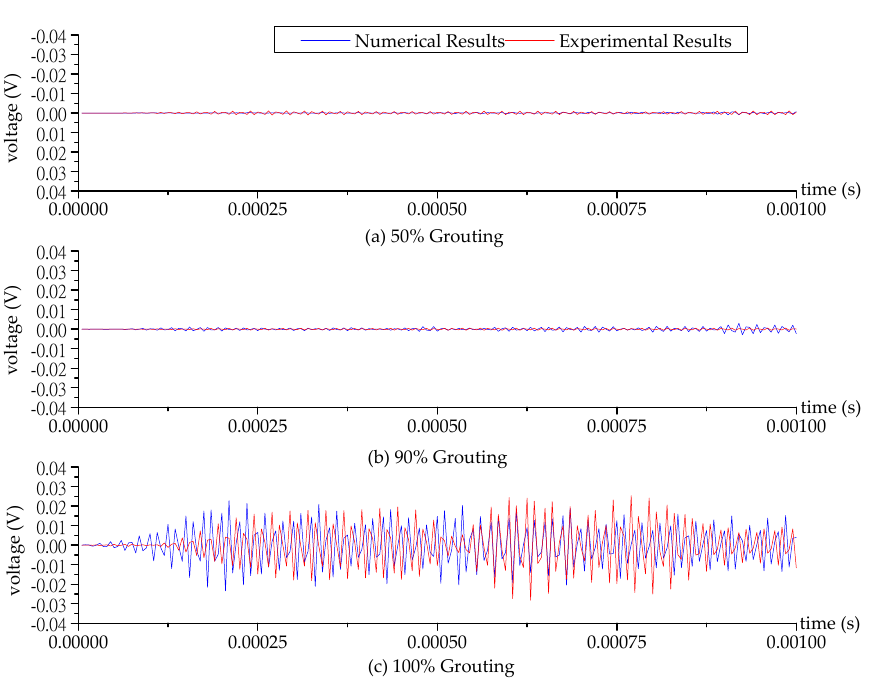
Figure 6. The numerical and experimental time-domain signal of the PZT 2 sensor at different grouting levels.